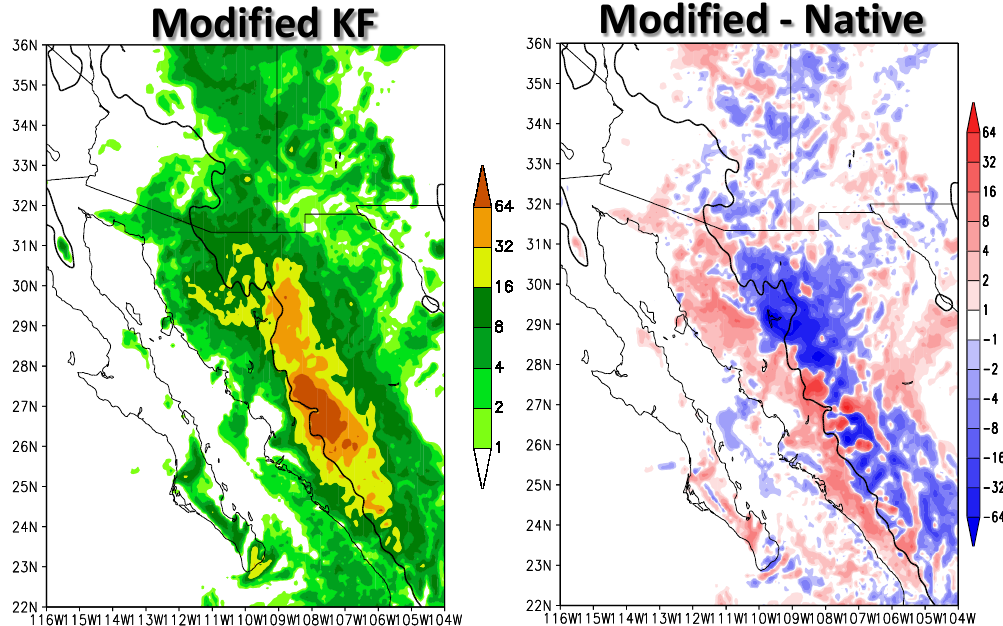
Figure 9. Accumulated precipitation (mm) for 24-h (12 UTC 13 July to 12 UTC 14 July) of NAME IOP2. Left : WRF simulation results for domain 2 (10 km) with native KF ( top ) and modified KF ( bottom ). Right : Equivalent results from NAME Tier-1 observational network ( top ), and difference between the 2 WRF simulations ( bottom ). Thin black contour on panels with WRF model results indicates the 1000 m elevation contour.